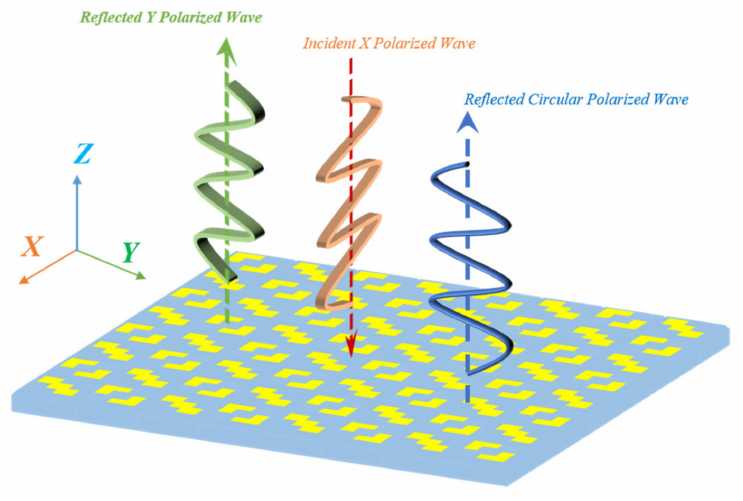
Figure 5. Schematic diagram of